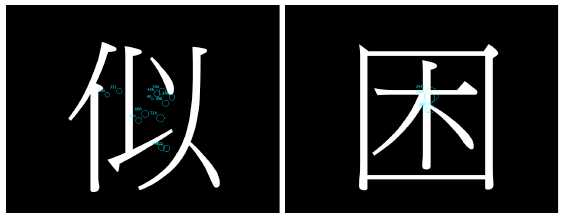
Figure 4. Vision distribution of Chinese characters